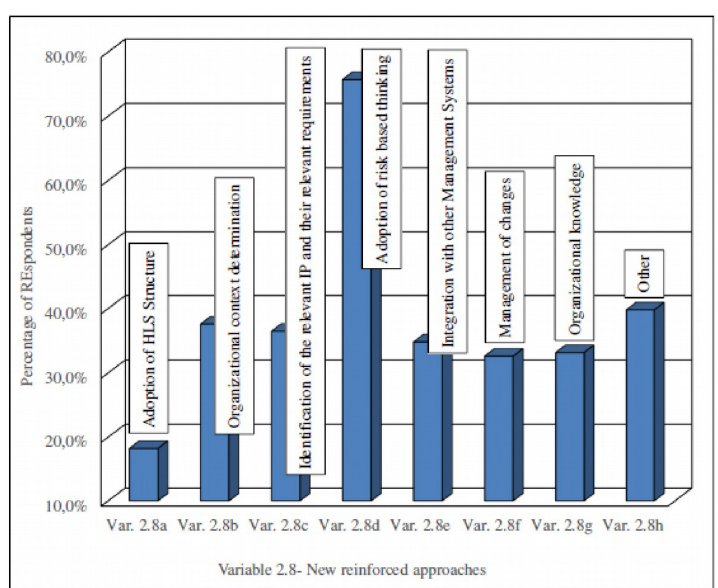
Figure 7. New/reinforced ISO 9001:2015 approaches considered more beneficial (% of